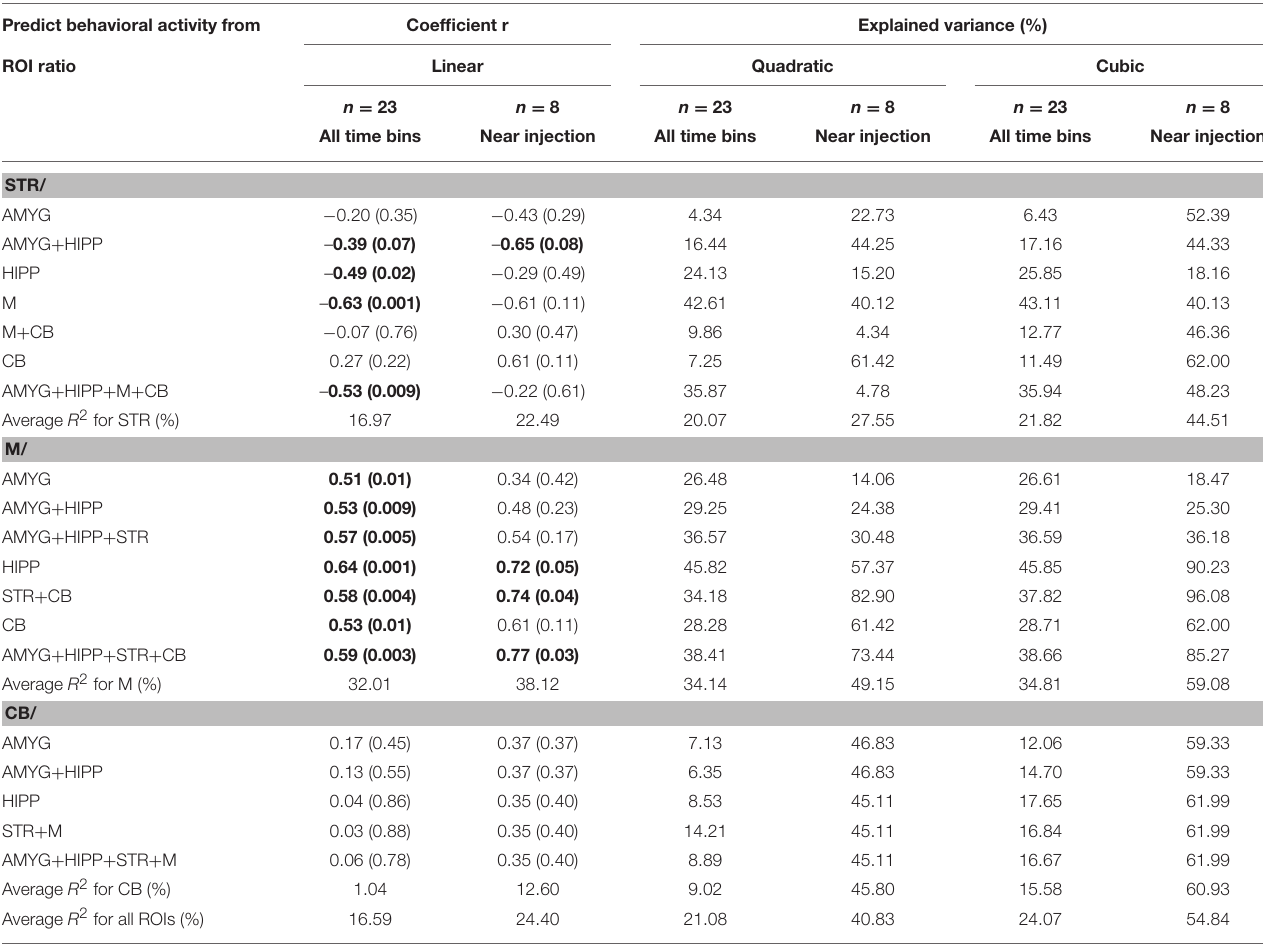
TABLE 4 | Changes in uptake in ROI relative to a reference region correlated with changes in behavioral activity across scan 2. Predict behavioral activity from Coefficient r Explained variance (%) ROI ratio Linear Quadratic Cubic